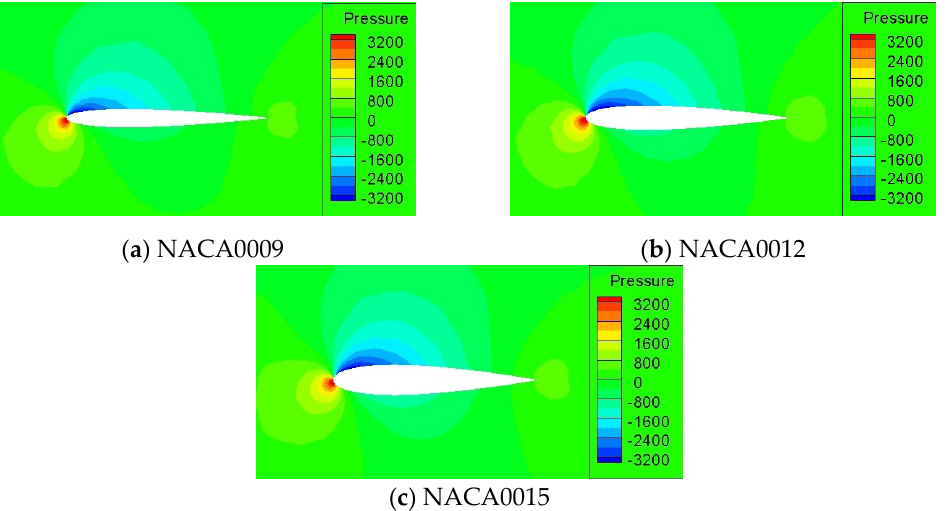
Figure 23. The surface pressure distribution on the advancing blade at 𝑟/𝑅 = 0.9 .